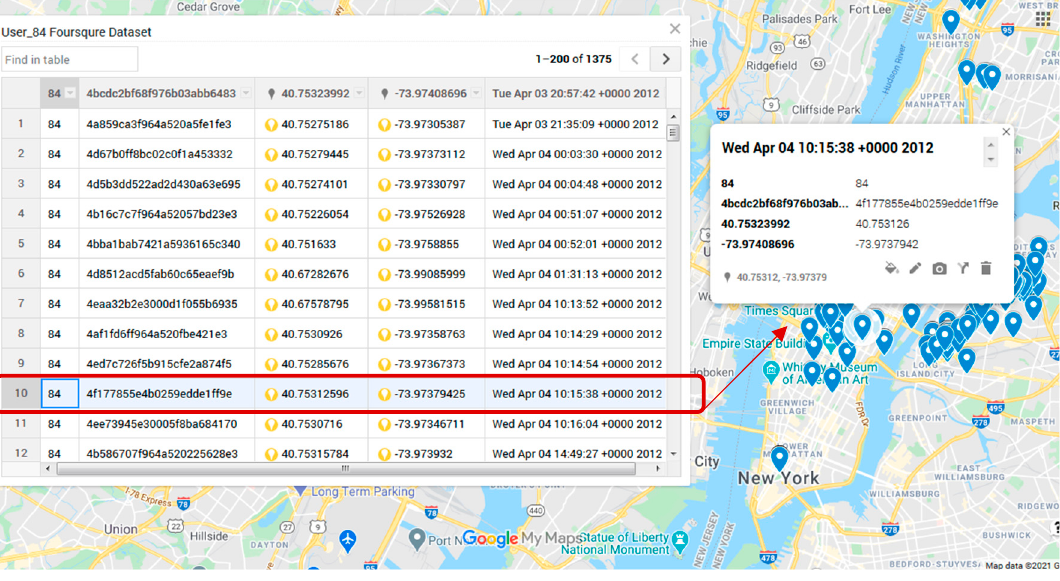
Figure 2. Features of the 10th user location record with ID 84 in the Foursquare dataset.